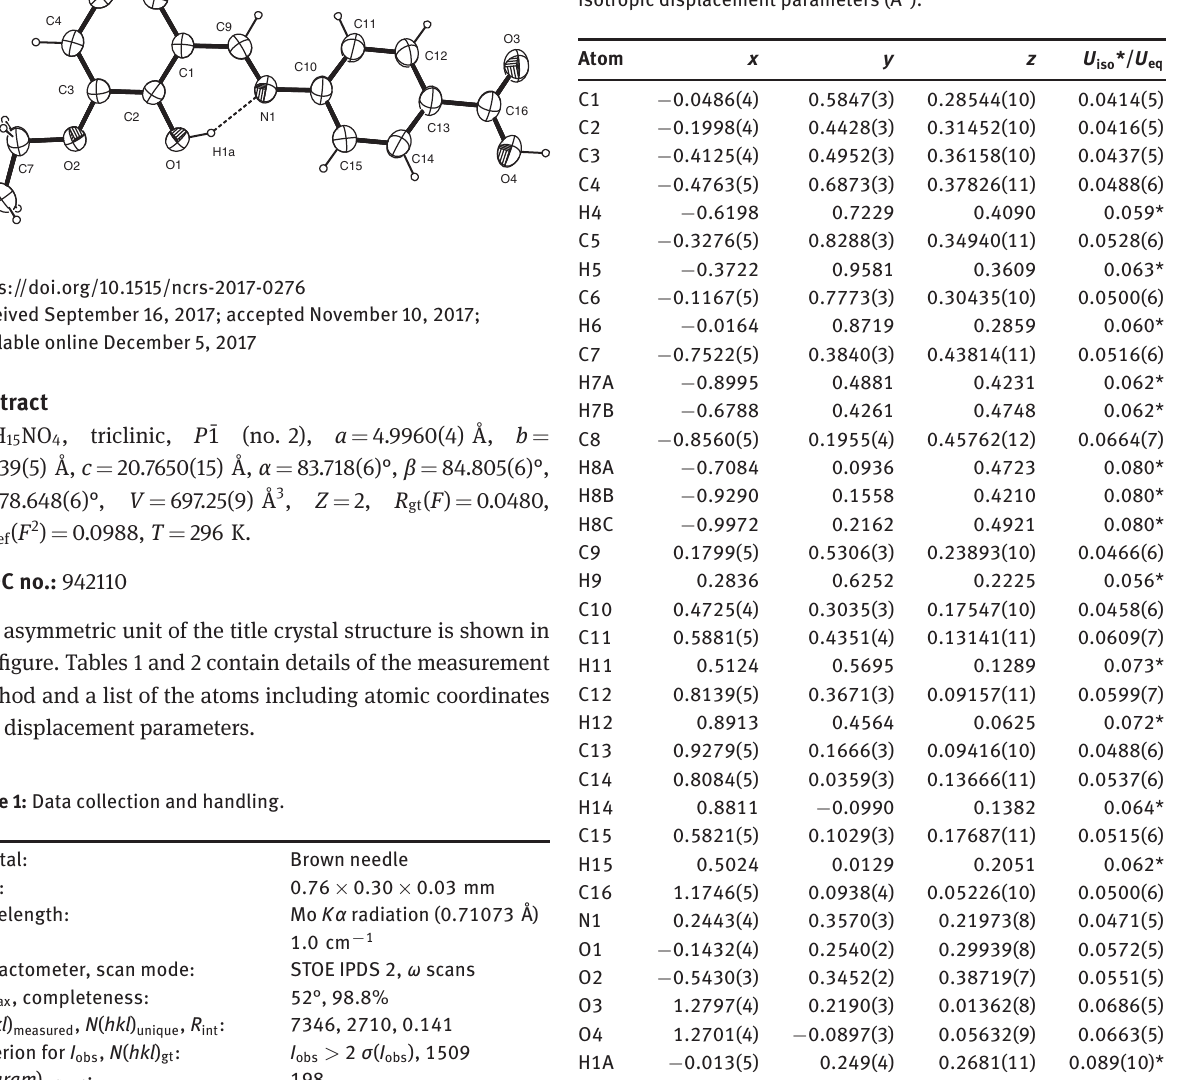
Table 2: Fractional atomic coordinates and isotropic or equivalent isotropic displacement parameters (Å 2